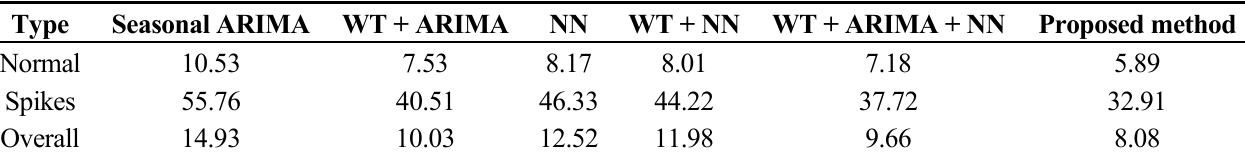
Table 4. AMAPE (%) obtained from different techniques for price forecasts in the Finnish day-ahead energy market of year